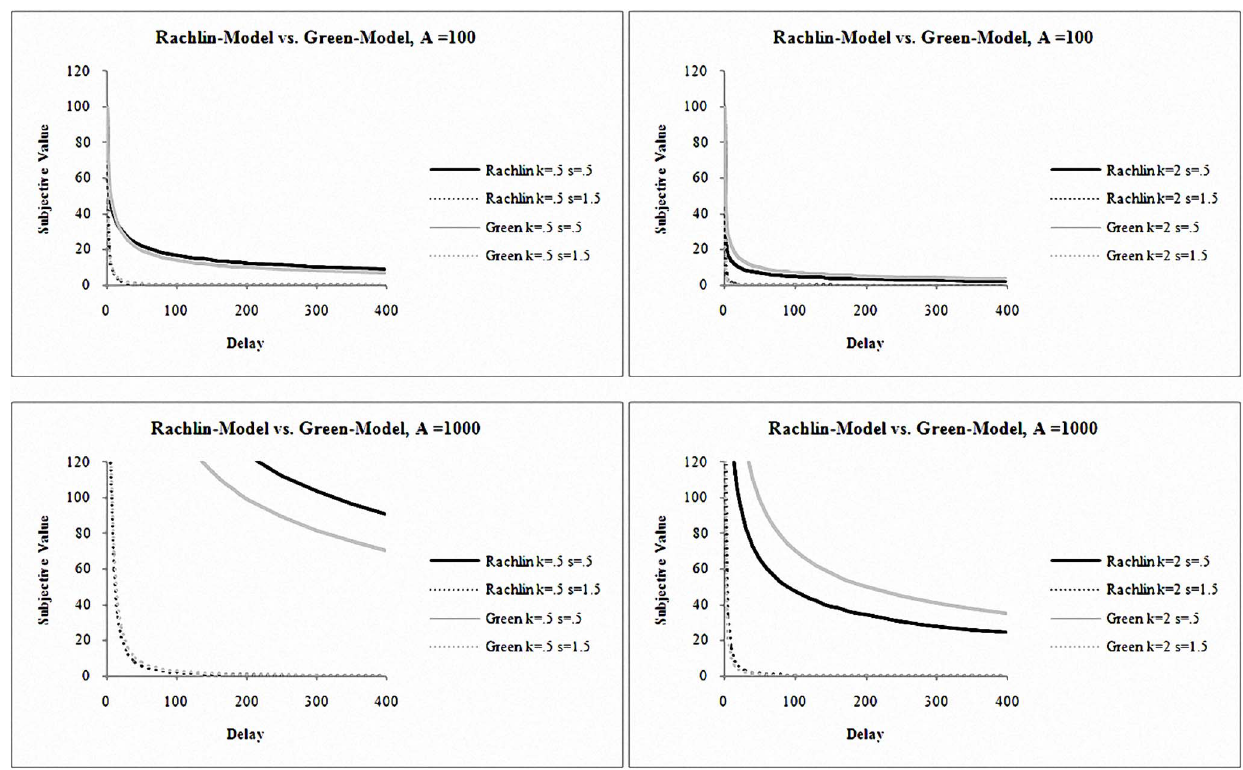
Figure 2. Rachlin- and Green-Models with varying parameters s =0.5 and 1.5; k =0.5 and 2. A=100 and 1000.